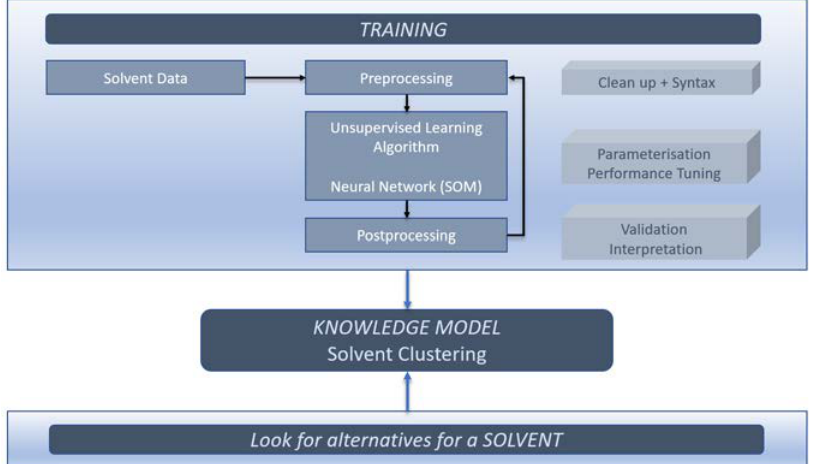
Figure 14. AI chain of events.